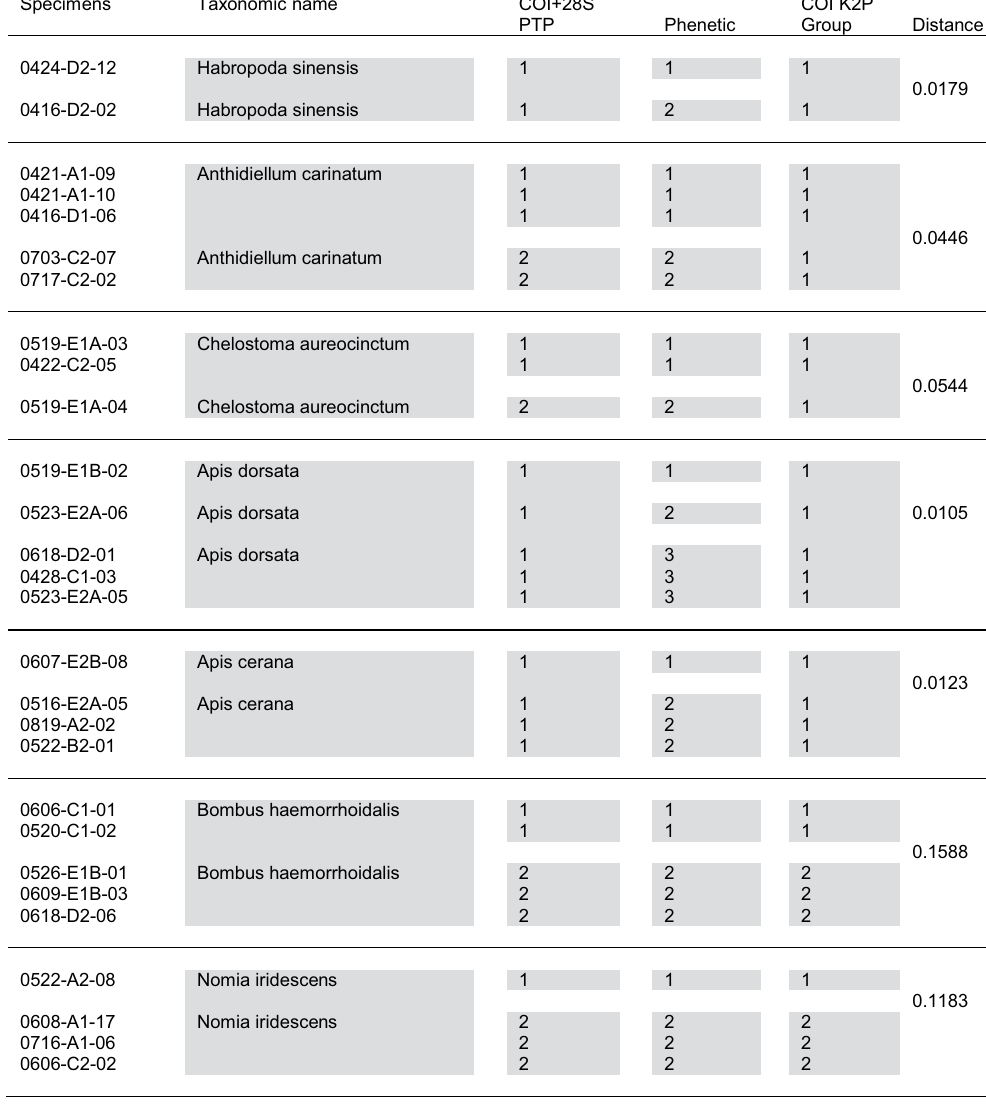
Figure 3. Seven incongruences remained after iterative delineation of OTU. No cases remained of two or more taxonomic species occurring in individual OTU. Molecular evidence was strong that the lower two species, Bombus haemorrhoidalis and Nomia iridescens , both were composed of two species. Molecular evidence for other cases was not conclusive. Column 1 gives specimen codes; note, where > 3 specimens were present in a OTU, only 3 are shown. Column 2 gives taxonomic name after morphological identification. Columns 3 and 4 give OTU from DNA taxonomy (2 methods) based on the two genes COI and 28 S. Columns 5 and 6 give groupings and K2P distance between specimens under question (split where > 9% divergence 15 ). Numbers in columns 3–5 depict different OTU (also by shaded